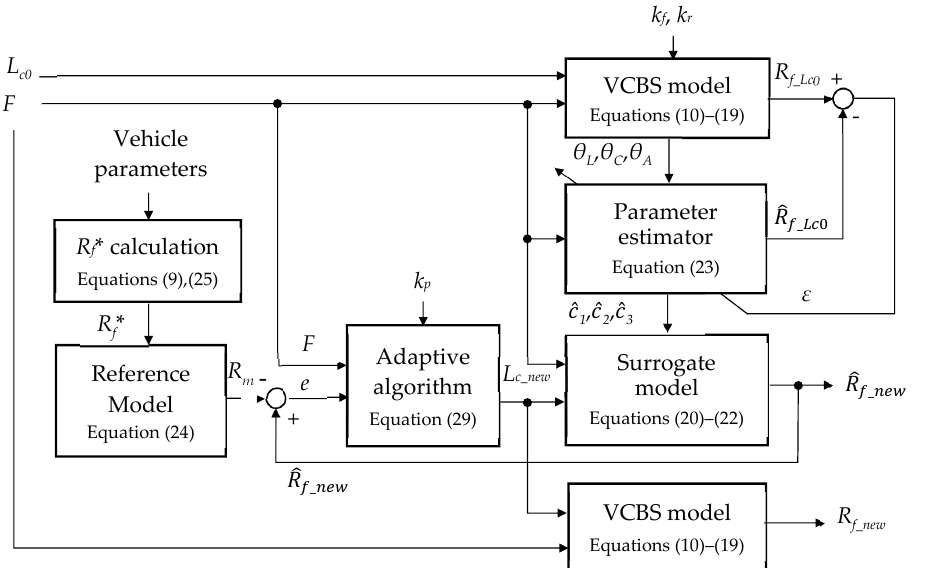
Figure 4. Block diagram for the cam profile design.